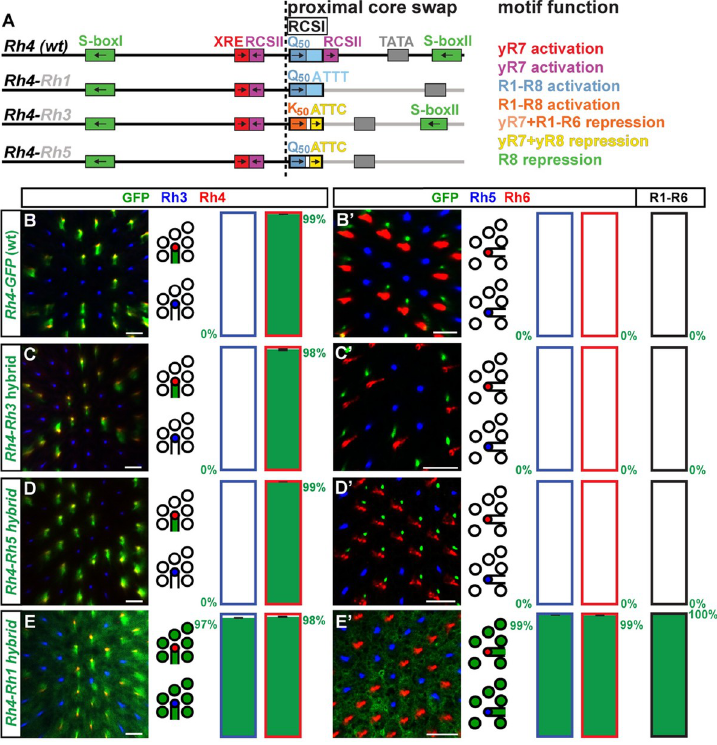
Fig 3. Compatibility of the unique Rh4 motifs with the proximal core motifs of Rh3 and Rh5 . (A) Schematic comparison of the wild type ( wt ) Rh4 promoter and hybrids of the distal Rh4 promoter combined with the proximal core promoters of Rh1 , Rh3 , or Rh5 . Note that the RCSI motifs of Rh1 and Rh4 are identical and that Rh3 and Rh4 share a proximal S-box motif for R8 repression. The dotted vertical line indicates the break/fusion point of the hybrids immediately upstream of the respective RCSI motif that is found in a similar position in all Rhs . (B)—(E) Wild type Rh4 vs . hybrid promoters driving GFP reporter expression (green) in the R7 layer. Rh3 (blue) labels pR7s and Rh4 (red) labels yR7s. Bar graphs show GFP co-expression in the Rh3 or Rh4 subset, respectively. (B’)—(E’) Wild type Rh4 vs . hybrid promoters driving GFP reporter expression (green) in the R8 layer. Rh5 (blue) labels pR8s and Rh6 (red) labels yR8s. Bar graphs show GFP co-expression in the Rh5, Rh6, or R1-R6 subset. Green numbers indicate the mean percentage of GFP co-expressing photoreceptors, error bar represents standard error of the mean. (B) and (B’) The wild type Rh4 promoter drives subtype-specific GFP expression in the yR7/Rh4 subset. Green staining in (B’) is from the axons of yR7s that traverse the R8 layer. N = 9 retinas and n = 949 R7s for (B); N = 9 retinas, n = 869 R8s and 5,214 R1-R6 PRs for (B’). (C) and (C’) The Rh4 - Rh3 hybrid drives subtype-specific GFP reporter expression in yR7s. Green staining in (C’) is from the axons of yR7s that traverse the R8 layer. N = 11 retinas and n = 1,327 R7s for (C); N = 12 retinas, n = 1,192 R8s and 7,152 R1-R6 PRs for (C’). (D) and (D’) The Rh4 - Rh5 hybrid drives subtype-specific GFP expression in yR7s. Green staining in (D’) is from the axons of yR7s that traverse the R8 layer. N = 12 retinas and n = 1,793 R7s for (D); N = 10 retinas, n = 730 R8s and 4,380 R1-R6 PRs for (D’). (E) and (E’) The Rh4 - Rh1 hybrid drives broad GFP expression in both R7 and R8 photoreceptor subtypes as well as R1-R6. N = 12 retinas and n = 1,024 R7s for (E); N = 10 retinas, n = 589 R8s and 3,534 R1-R6 PRs for (E’). Scale bars, 10 μ